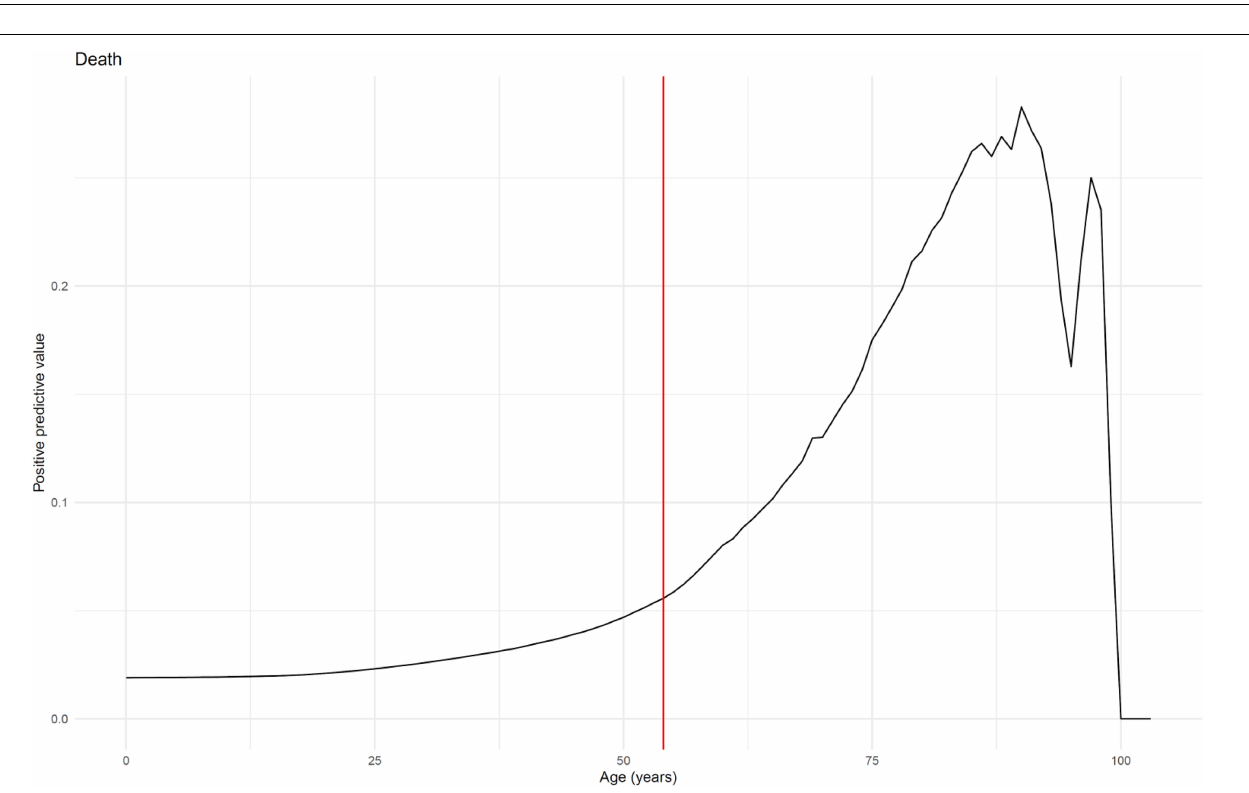
CI 0.27, 0.07–0.98) variants. Among those under 55 years, for any of the Alpha/20I, Delta/21A and Marseille-4/20A.EU2